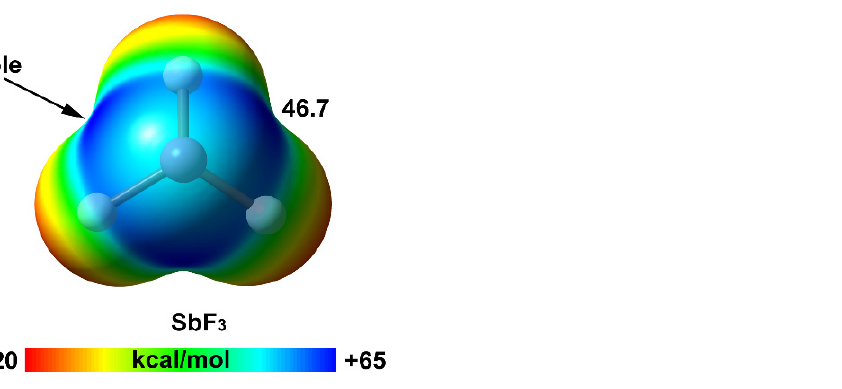
Table 2. Catalyst candidates used and dissociation constants (K D in μ M) of chloride complexes in THF. Ph and PFP stand for phenyl and pentafluorophenyl moieties, respectively.